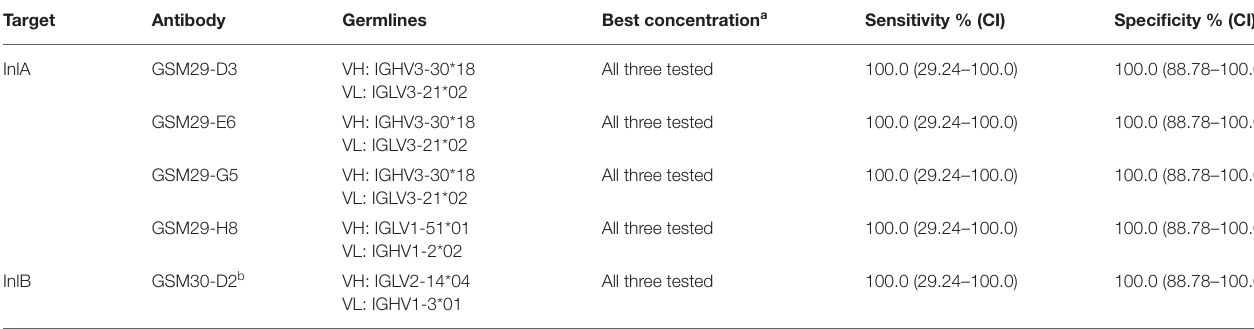
TABLE 2 | Diagnostic performance of four scFv-Fc targeting InlA and one against InlB. Target